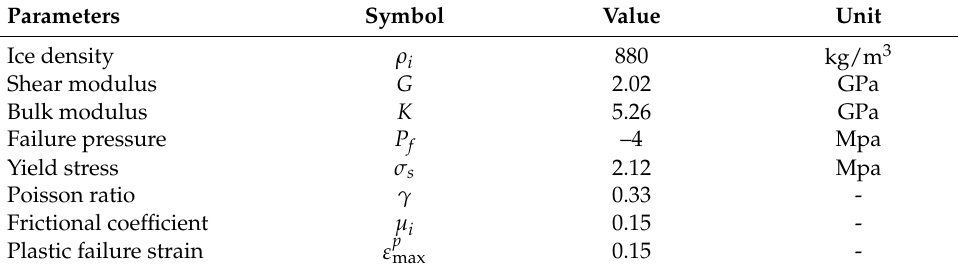
Table 1. Parameters of sea ice materials in the numerical model.